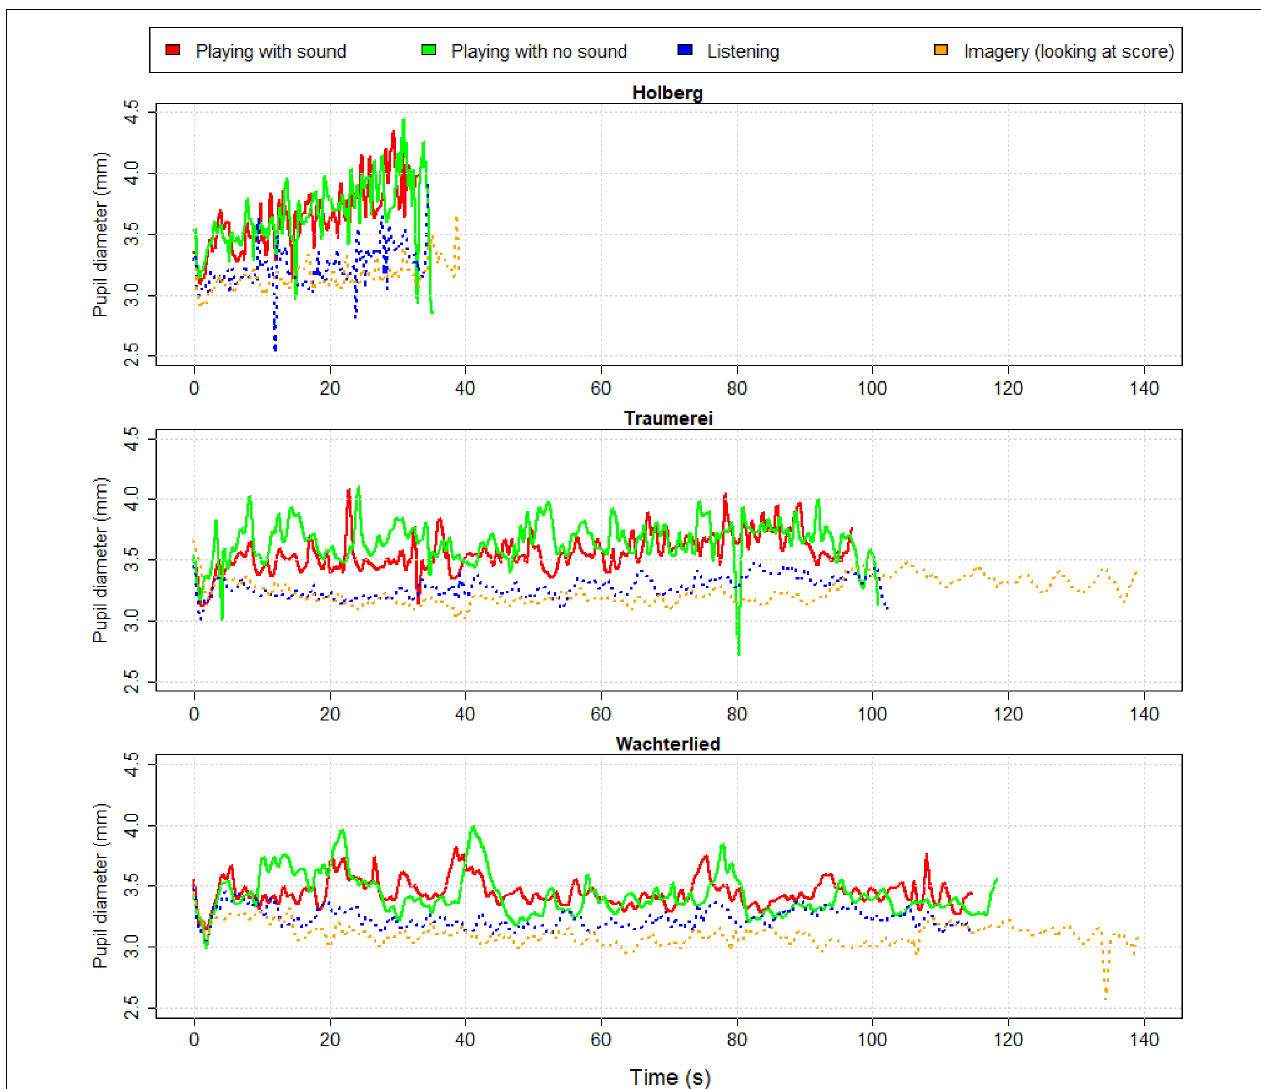
FIGURE 3 | Pupillary waveforms of professional pianist (PP) during each of the three piano excerpts (Holberg Suite, Traäumerei and Wächterlied) and for each of the four conditions (“Playing with sound”—red line, or “Playing with no sound”—green line, “listening”—blue dotted line, and “imagery”—orange dotted